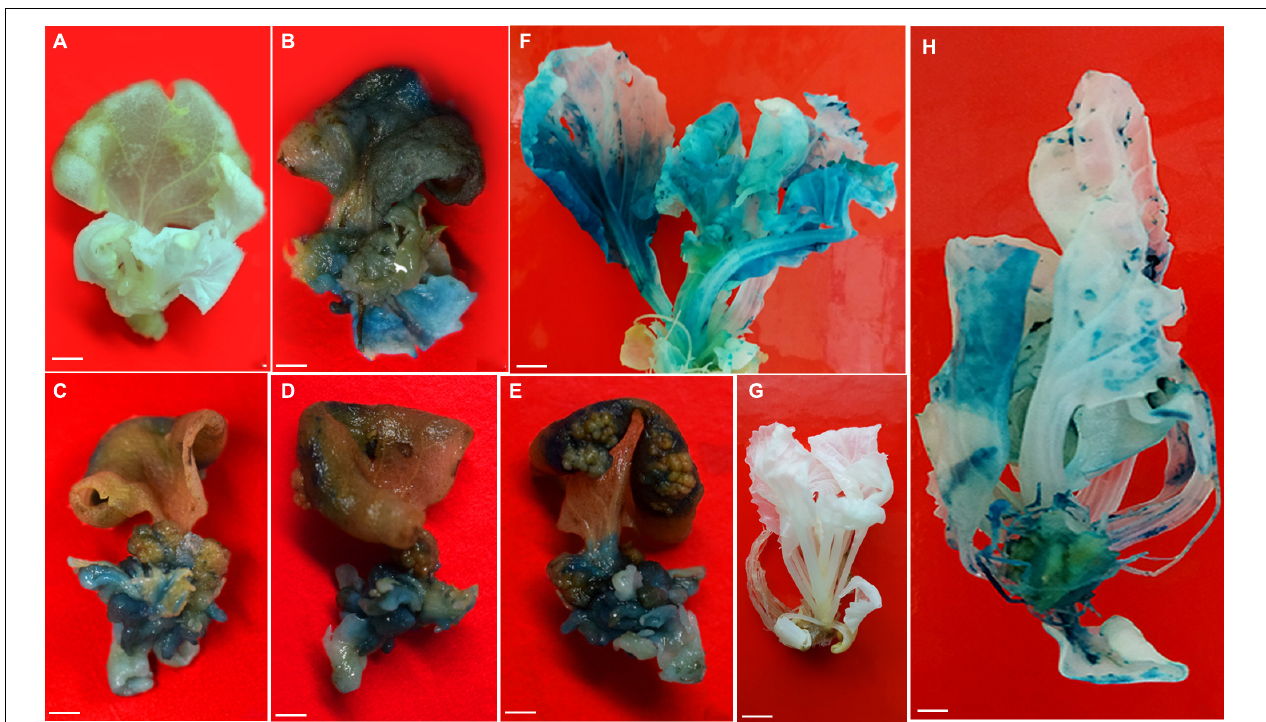
FIGURE 3 | Stable expression of gusA gene in Chinese cabbage. (A) Control cotyledon explants with initiation of shoots from petiole region. (B–E) GUS expression in adaxial and abaxial sides of cotyledon explants with initiation of shoots. (F) GUS expression in fully grown shoots. (G) Control rooted plantlet. (H) GUS expression in rooted plantlet. Scale bar represents (A–E) 20 mm, (F–H) 1 cm.